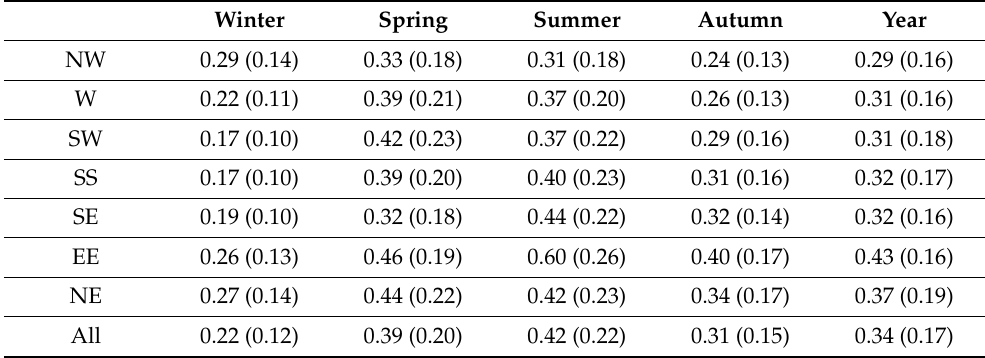
Table 3. Lower limits of the 10% highest seasonal AOD 550 and seasonal average AOD 550 (in brackets) across seven cells around the Urmia Lake. Winter Spring